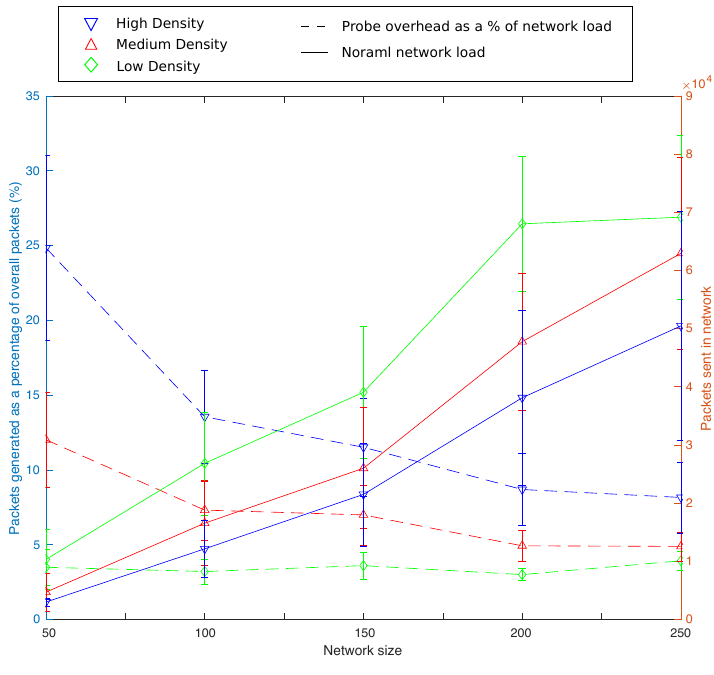
Figure 6. Mean and standard deviation for the maximum percentage load incurred using the probing technique over normal network